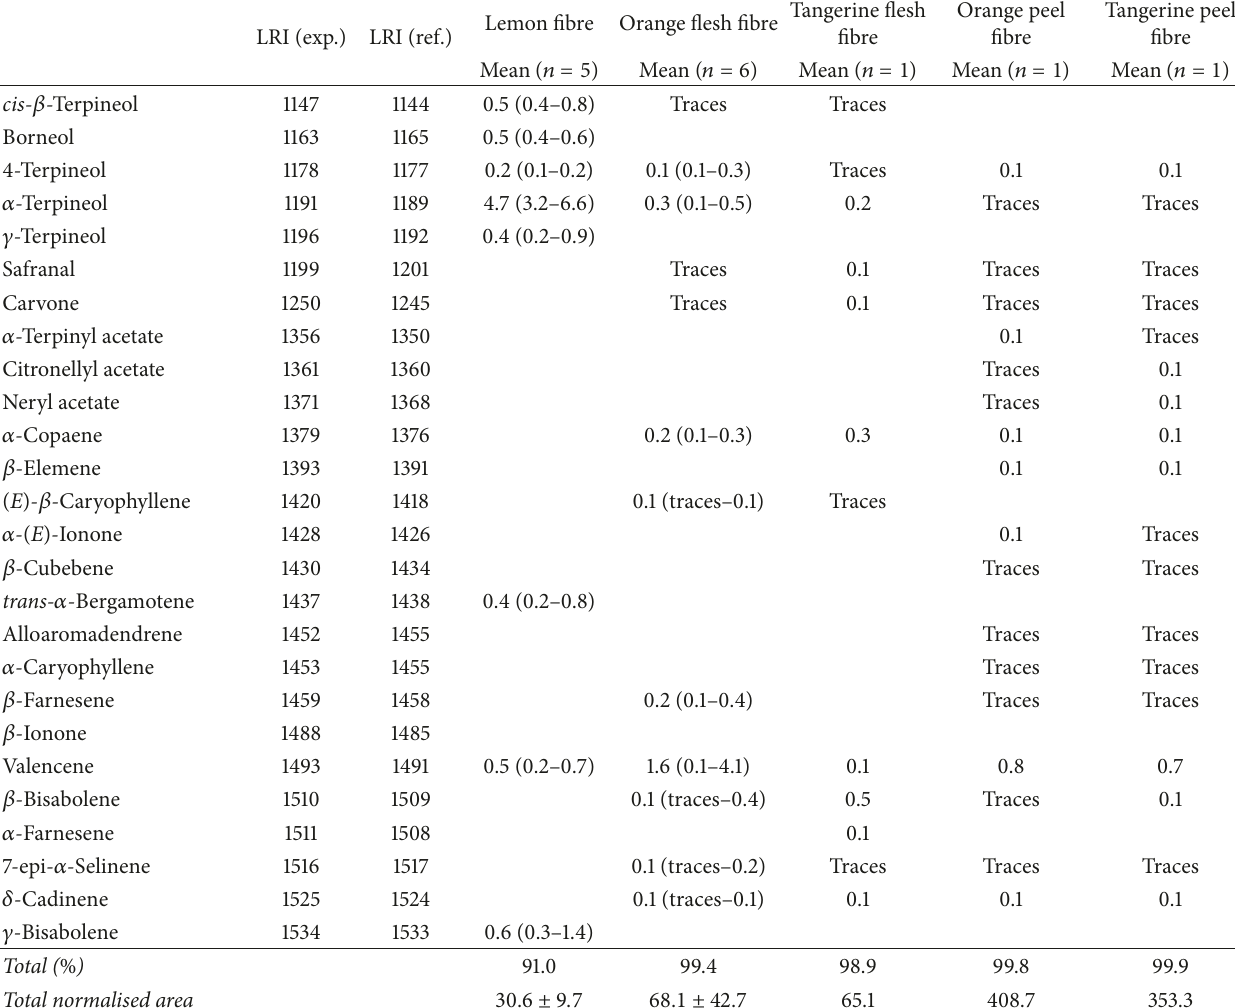
(Table 3). A high ER was measured for the R -limonene enantiomer ( > 99%). 𝛼 -Pinene and 𝛼 -ionone in carrot fibre were present with a higher ER in favour of the S -enantiomer, while 𝛽 -pinene in pear was present in a racemic form. 𝛼 - Terpineol was found in all samples, with a higher